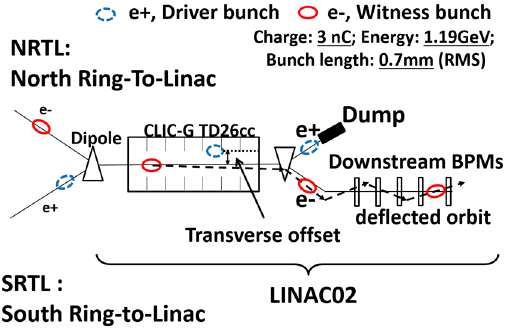
FIG. 2. Layout of the experiment. FIG. 3. The tested CLIC-G prototype